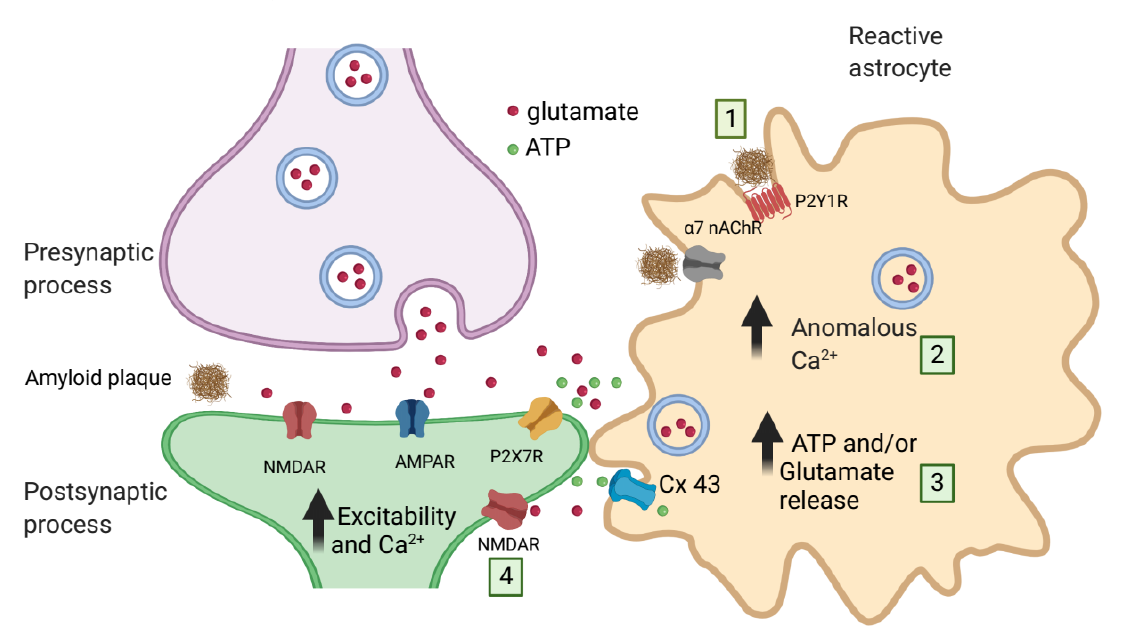
Figure 2. Schematic representation of ATP and glutamate release from astrocytes in AD pathology. (1) Amyloid plaques react with P2Y1R or α7 nAChRs to evoke anomalous and increased intracellular calcium increases in astrocytes (2). These calcium increases induce the release of glutamate and/or ATP via vesicle release or hemichannel Cx43 release (3). ATP and glutamate act on P2X7Rs or NMDARs to increase the excitability and calcium concentrations of neurons (4). Arrows indicate increases.